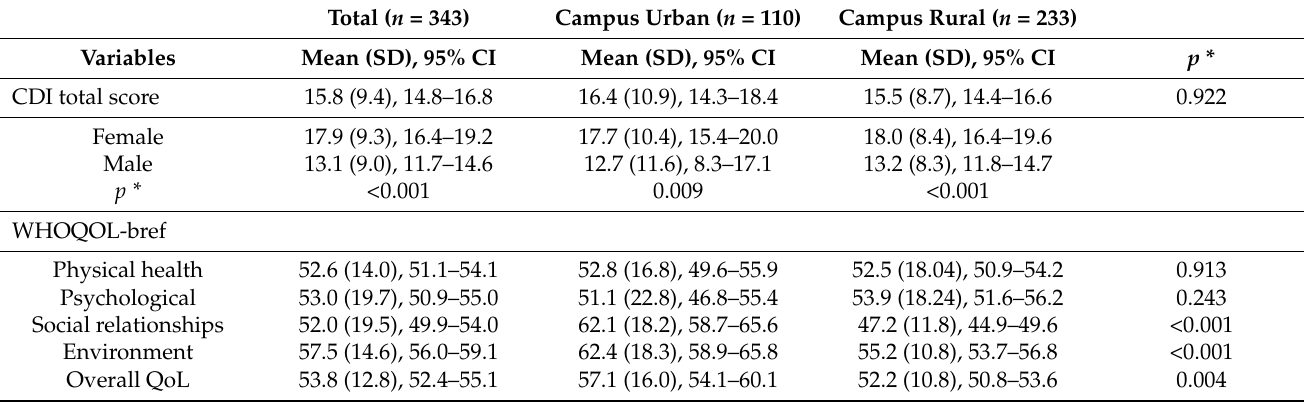
Table 3. Mean CDI and WHOQOL-bref scores, stratified by